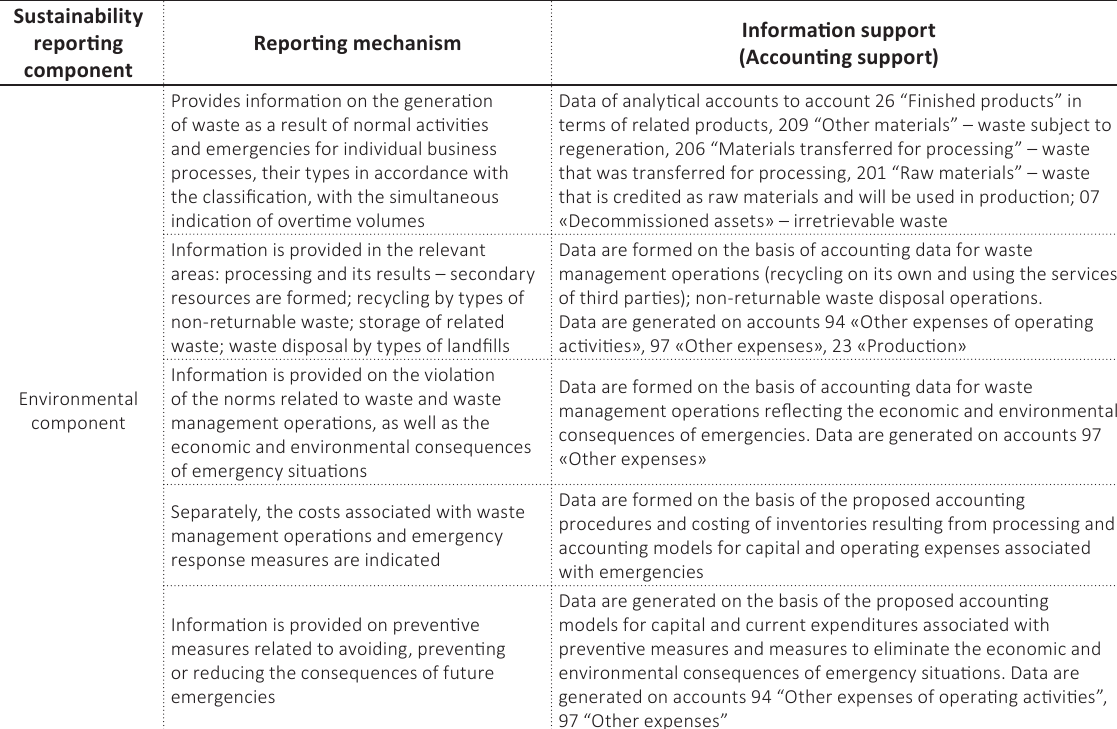
Table 3. Accounting support to generate a fragment of sustainability reporting: the environmental